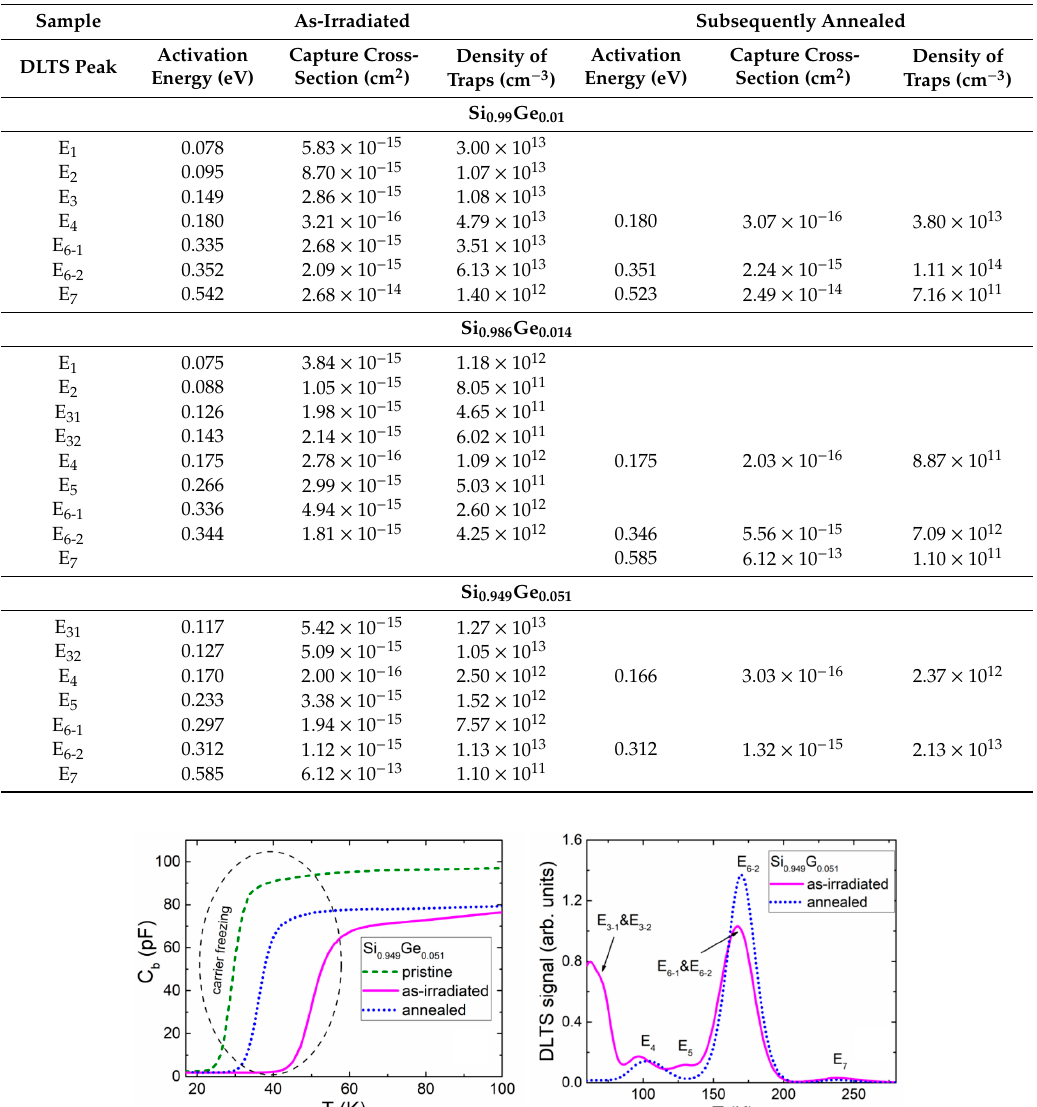
Table 2. Summary of traps revealed for the as-irradiated and subsequently annealed SiGe samples with di ff erent Ge content.